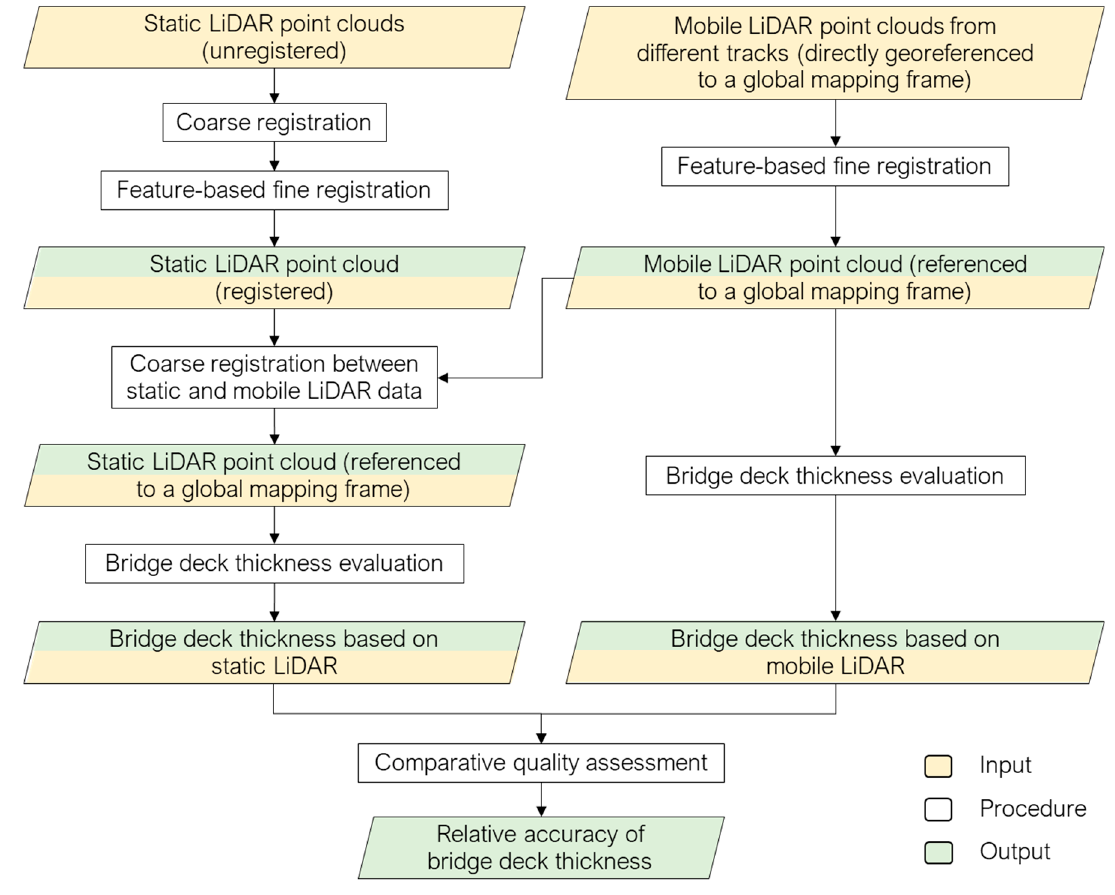
Figure 5. Workflow of the proposed bridge deck thickness evaluation and comparative quality assessment strategy.